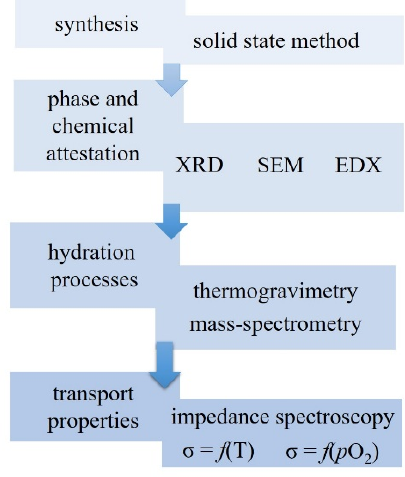
Figure 3. The scheme indicating the workflow and analysis.